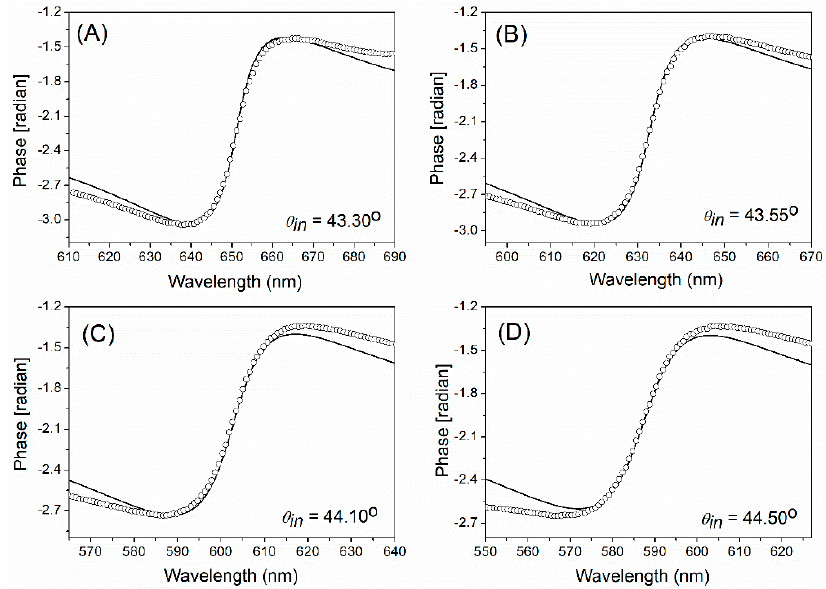
Figure 5. At other incident angles ( θ in ) of light, the phase calculated using the KK relation (empty circles) in comparison to the phase directly obtained from r ( λ ) calculated from a field transfer matrix formula Equation (1) (solid curves). The phase offsets used are φ 0 = − 2.28, − 2.20, − 2.06, − 2.00 radians for ( A – D ), respectively.